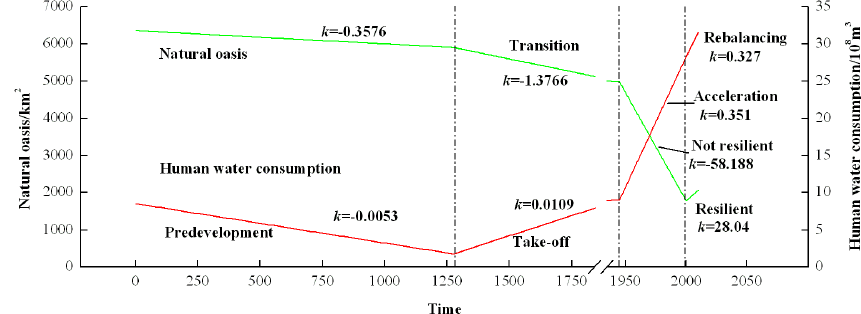
Figure 6. The development stages of evolutionary processes of human–water relationships.